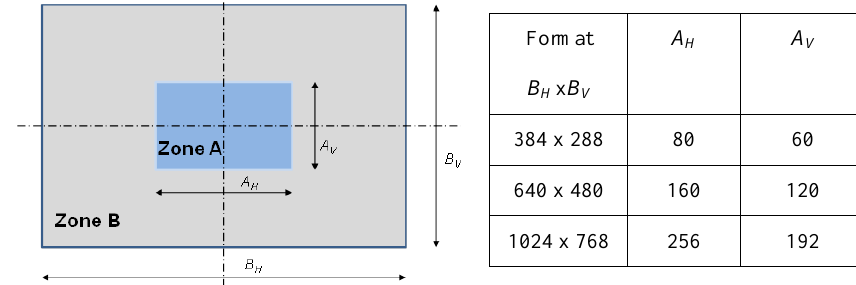
Figure 8. Typical subdivision of infrared microbolometer arrays in the mid (zone A) and marginal zones (zone B).